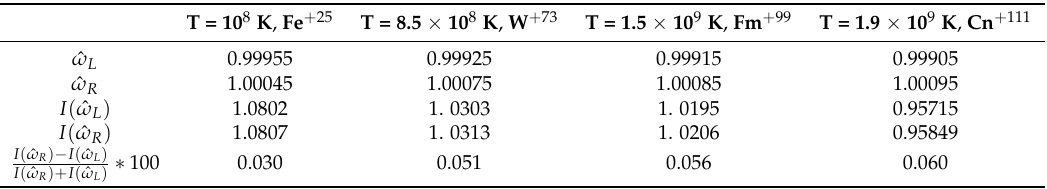
Table 1. Asymmetry percentages for different hydrogen-like